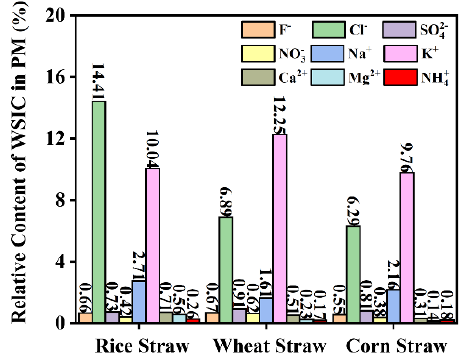
Figure 5. The relative content of WSIC in PM.